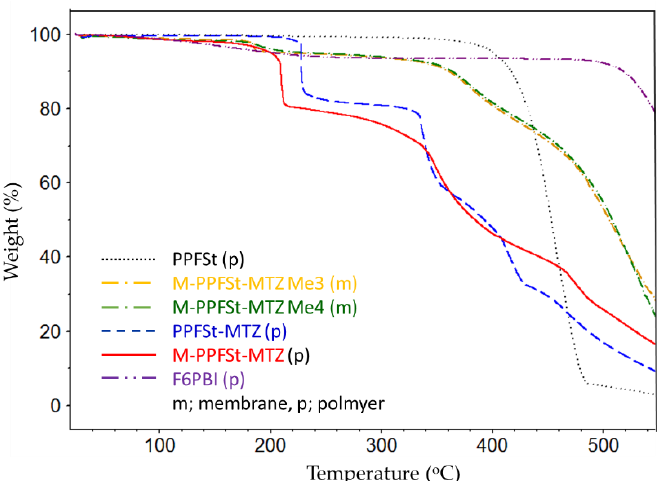
Figure 5. The thermal stabilities of polymers and membranes used in this study.